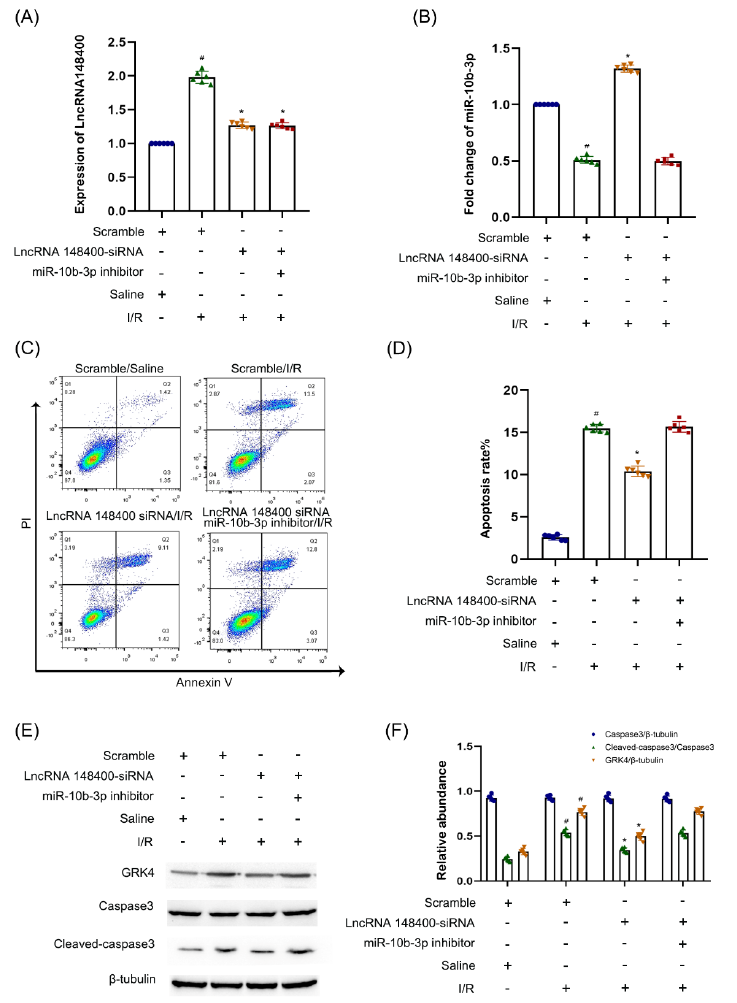
Figure 7. Knock down of LncRNA148300 attenuated the I/R induced BUMPT cell apoptosis was reversed by anti −miR−10b−3p . BUMPT cells were co-transfected with100 nM lncRNA148400 siRNA plus with or without anti −miR−10b−3p , and then treated with I(2 h)/R(2 h) injury. ( A ) RT−qP CR analysis the expression of LncRNA148400. ( B ) RT − qPCR analysis of the expression of miR−10b−3p . ( C ) FCM analysis of apoptosis in BUMPT cells. ( D ) Representative apoptosis rate (%). ( E ) Immunoblot analysis of the expression of Caspase 3, cleaved-caspase3, GRK4, and β− tubulin. ( F ) The gray analysis between them. Densitometric measurement of protein signals. Data are expressed as mean ± SD ( n = 6). # p < 0.05 vs. saline with scramble group; * p < 0.05 vs. I/R with LncRNA148400 siRNA group.